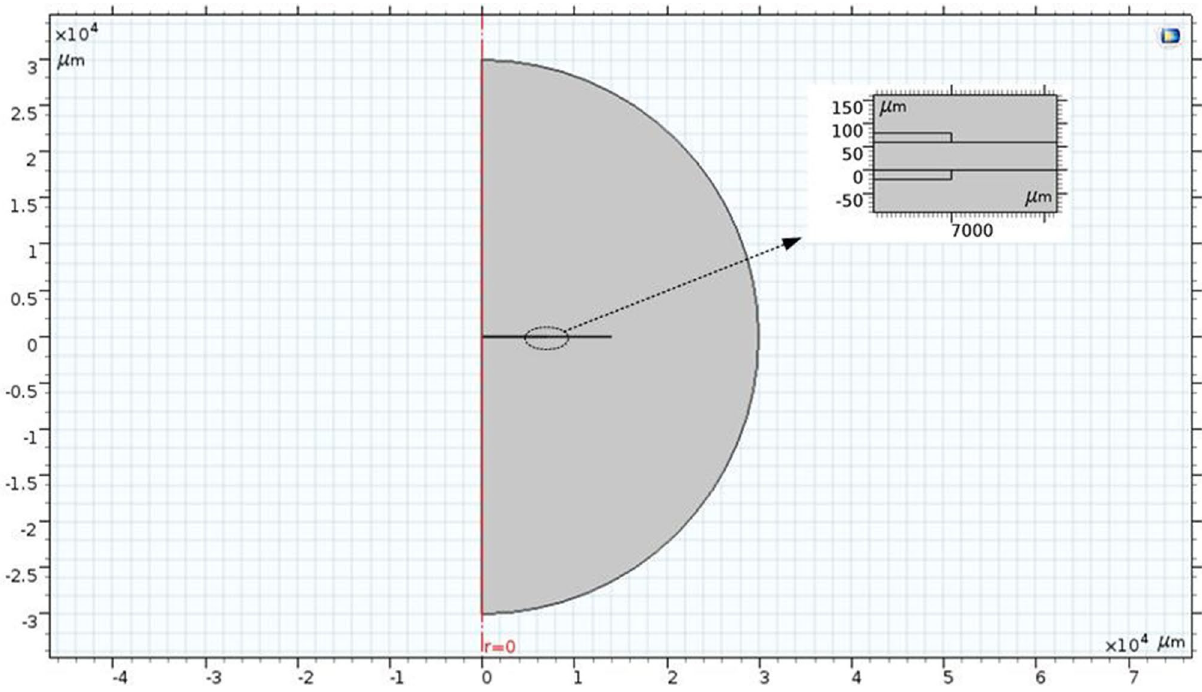
Figure 5. Geometric modeling diagram of electrostatic model simulation by COMSOL Multiphysics